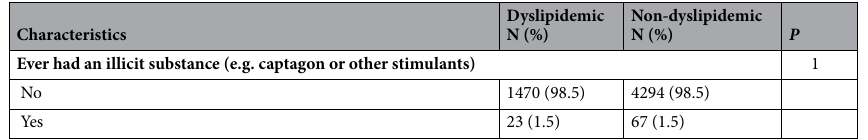
Table 3. Characteristics of dyslipidemic and non-dyslipidemic adolescents. BMI body mass index, IQR interquartile range, min minutes, N number of participants, P P value (t-test for continuous variables and χ 2 for categorical variables), RBC red blood cells count, TV television. Significant values are in bold.